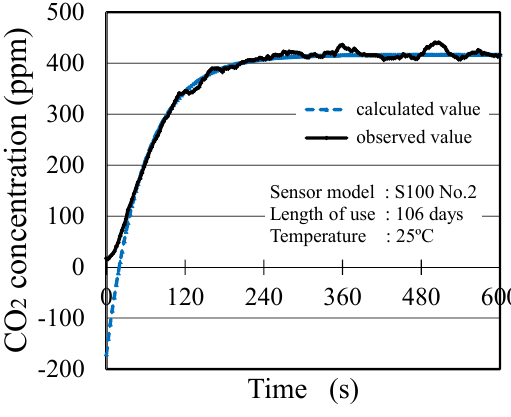
Figure 7. Time course of the output of S100 sensor model. Solid line shows actual sensor output value. Dotted line shows CO concentration estimated using α and τ 2